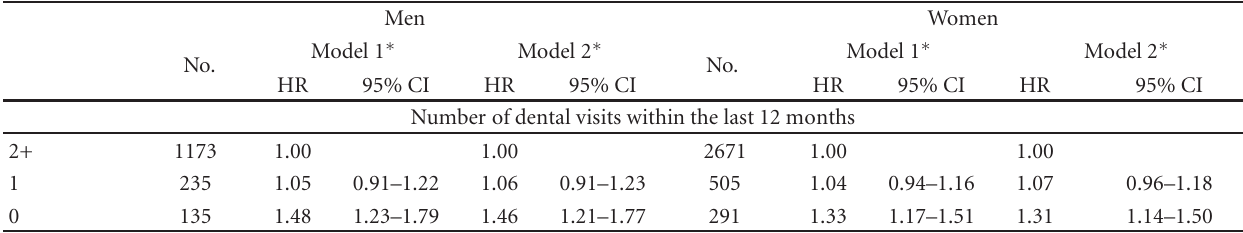
Table 4: Hazard ratios for mortality by dental health behaviors among subjects with dentures, Leisure World Cohort Study, 1992–2009.